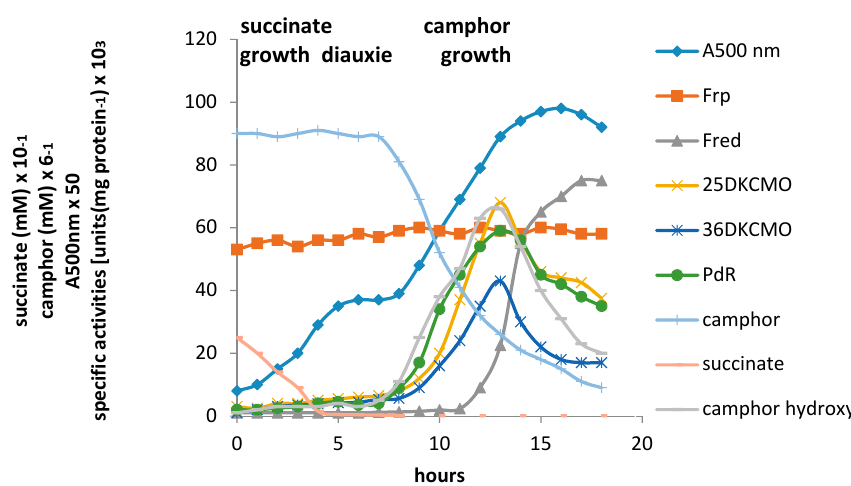
Figure 6. Changes in the optical density (A 500 nm), succinate (mM), ( rac )-camphor (mM), and the specific activity of key enzymes of ( rac )-camphor degradation during diauxic growth of P. putida ATCC 17543 on succinate plus ( rac )-camphor-based defined medium.